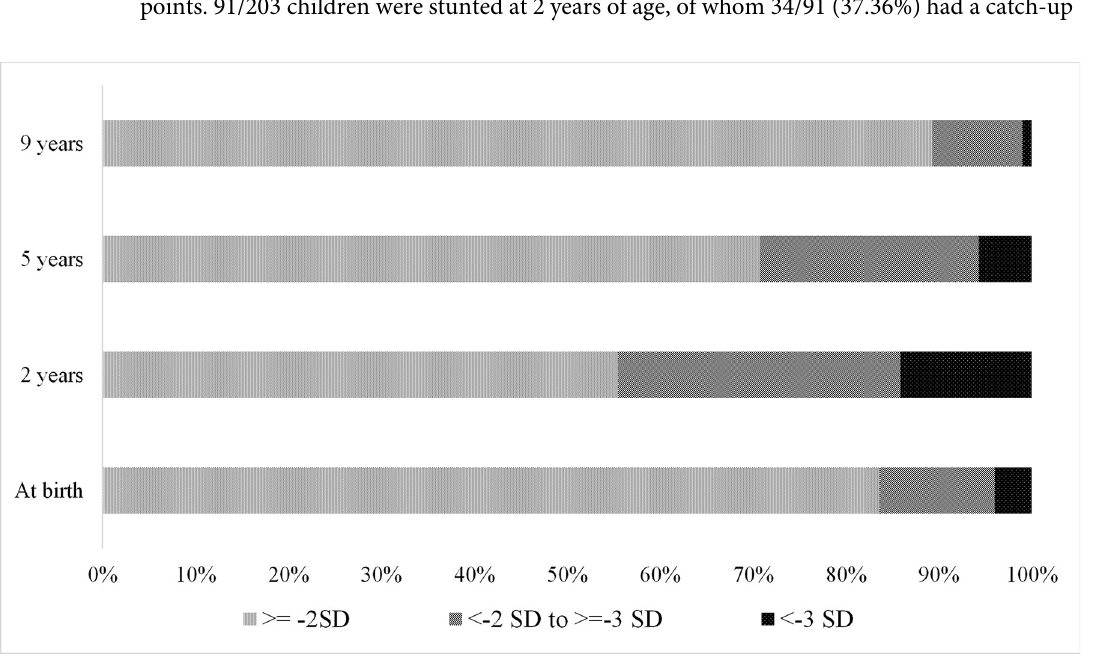
About 203/251 children in the cohort had complete information on stunting at all time points. However, to study the association between early childhood stunting with/without a catch-up at later ages and cognition at 9 years, only 200/203 were considered for analysis. Remaining 3/203 children were not included in the analysis, as 2/3 children were stunted only at 5 years and the other child only at 9 years, with normal growth parameters at other time- points. 91/203 children were stunted at 2 years of age, of whom 34/91 (37.36%) had a catch-up